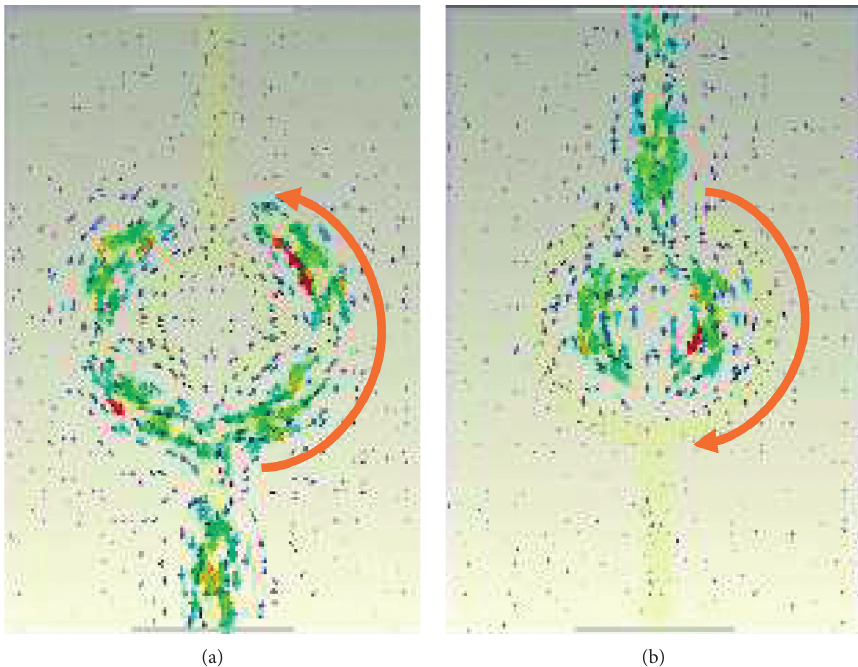
Figure 8: Surface current distribution due to (a) Port 1 and (b) Port 2.